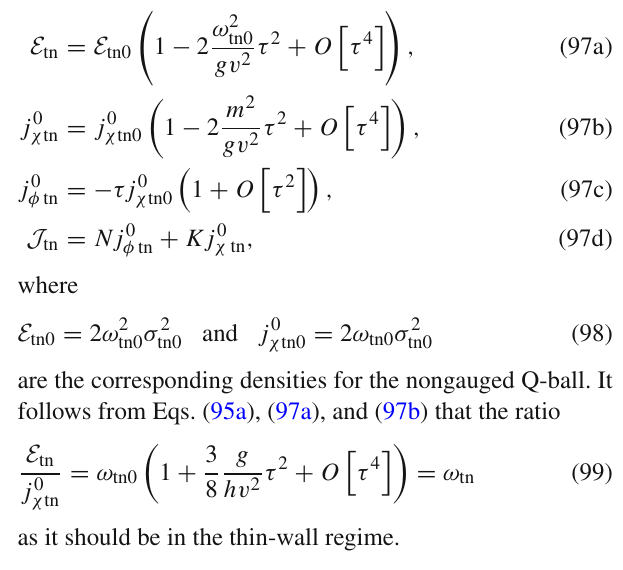
( τ = ˜ q / ˜ e = 1), and may vary in some interval. In addition